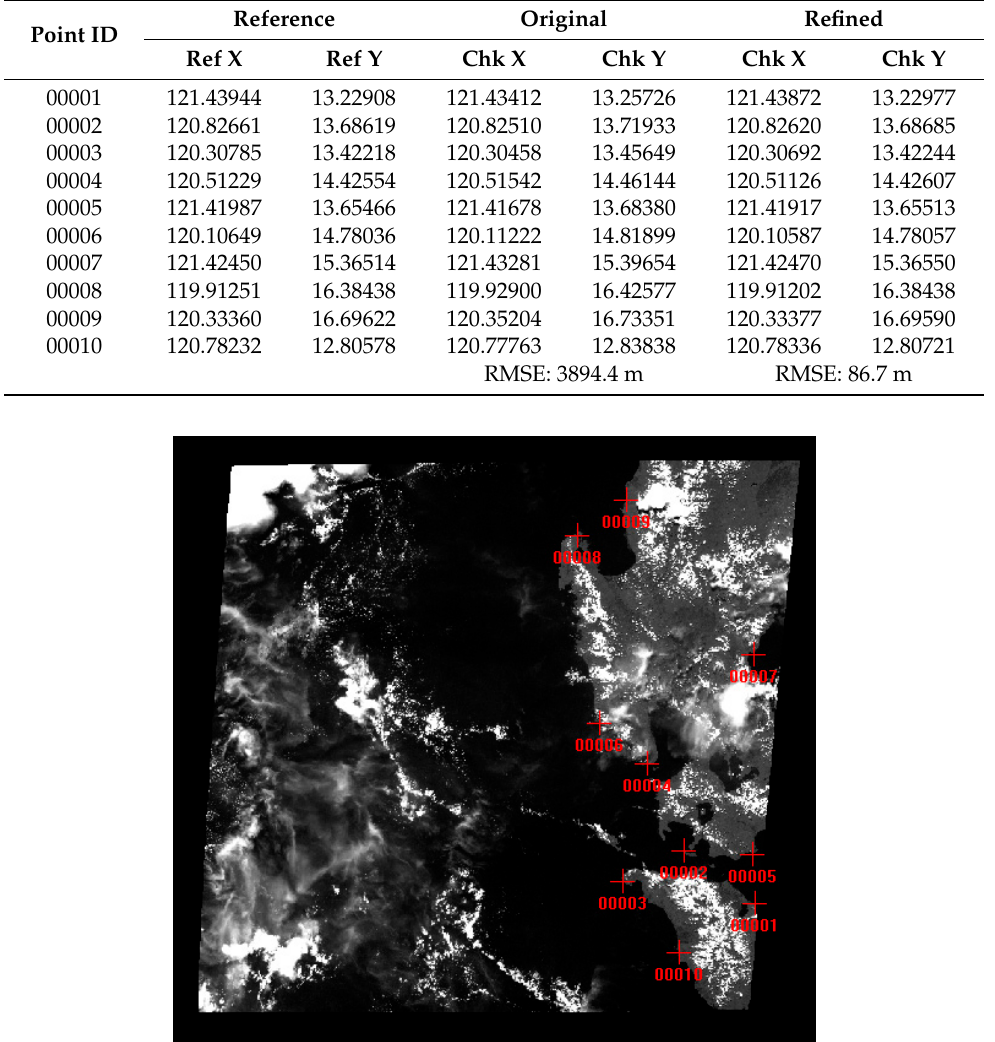
Figure 12. This shows the distribution of the checking points. Table 4 . This table shows the checking points list.